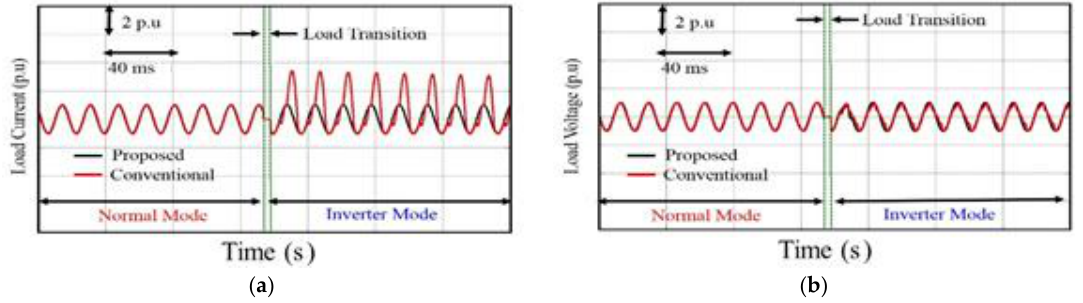
Figure 20. ( a ) Load current; and ( b ) load voltage for the conventional and proposed single-phase offline UPS topologies when the inverter voltage is injected at 240°.